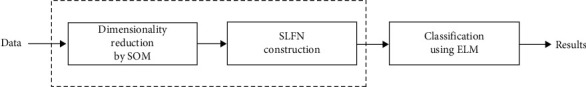
The sketch map of the proposed method.